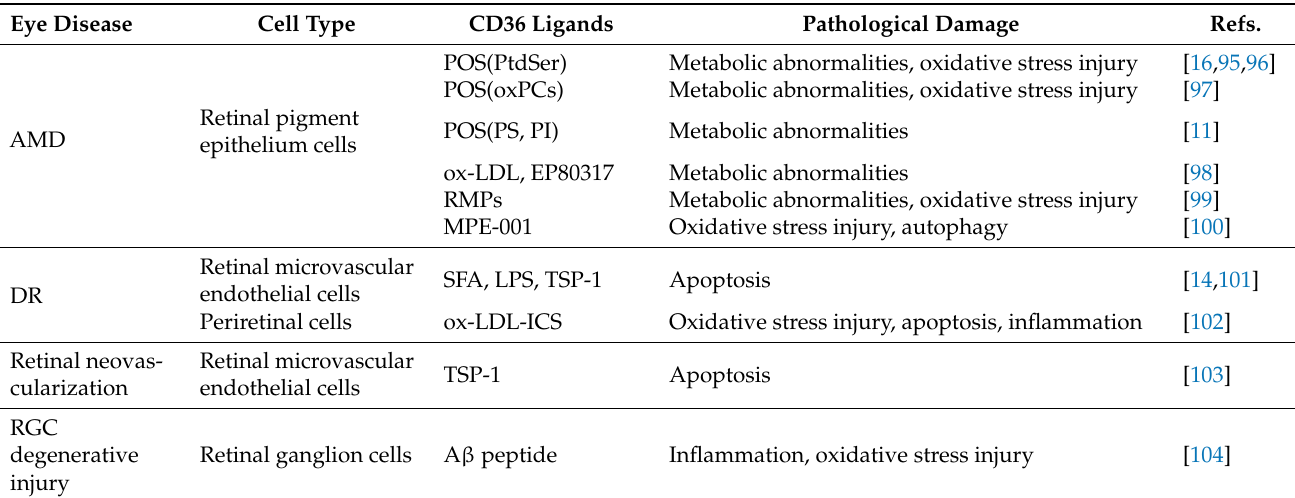
Table 1. The roles of CD36 in different cell types and eye